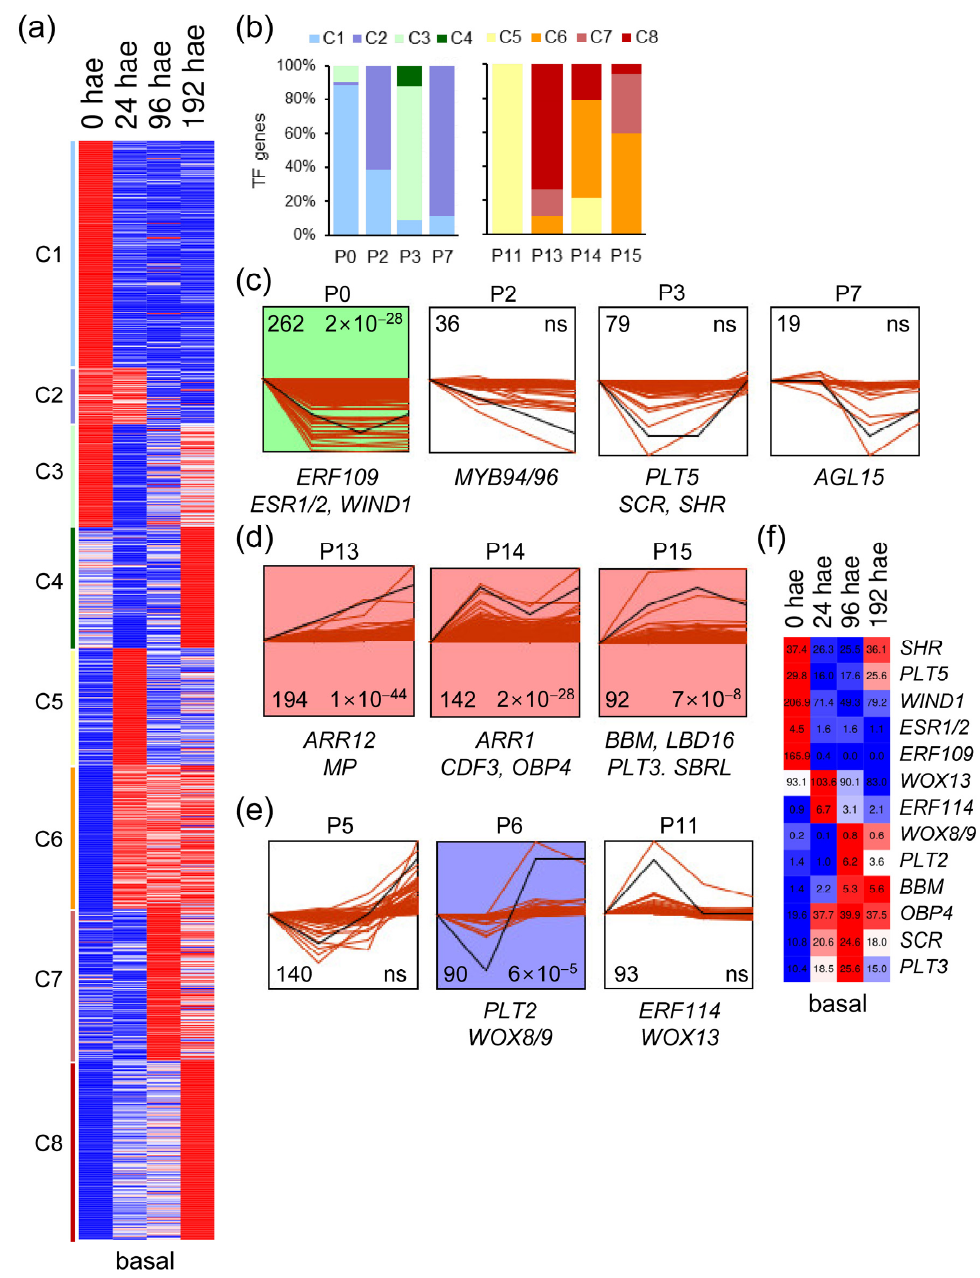
Figure 3. Expression profiles of TF genes during de novo AR formation. ( a ) K-means analysis of the different TFs expressed in the basal region of the hypocotyl over time. ( b ) Percentage of k-means clusters associated with each expression profile. ( c – e ) Selected expression profiles of downregulated TF genes identified in STEM. Some TFs whose A. thaliana orthologs are known to be involved in regeneration are indicated. The numbers in the left corner indicate the number of TF genes in each expression profile, and the numbers in the right corner indicate the p value; ns: not significant p value. ( f ) Heatmap of selected TF genes with differential expression in the basal region of the hypocotyl. Blue/white/red in ( a , f ) indicate normalized cpm values in each row, where red indicates the highest abundance of transcripts. Gene annotations are found in Table S1.